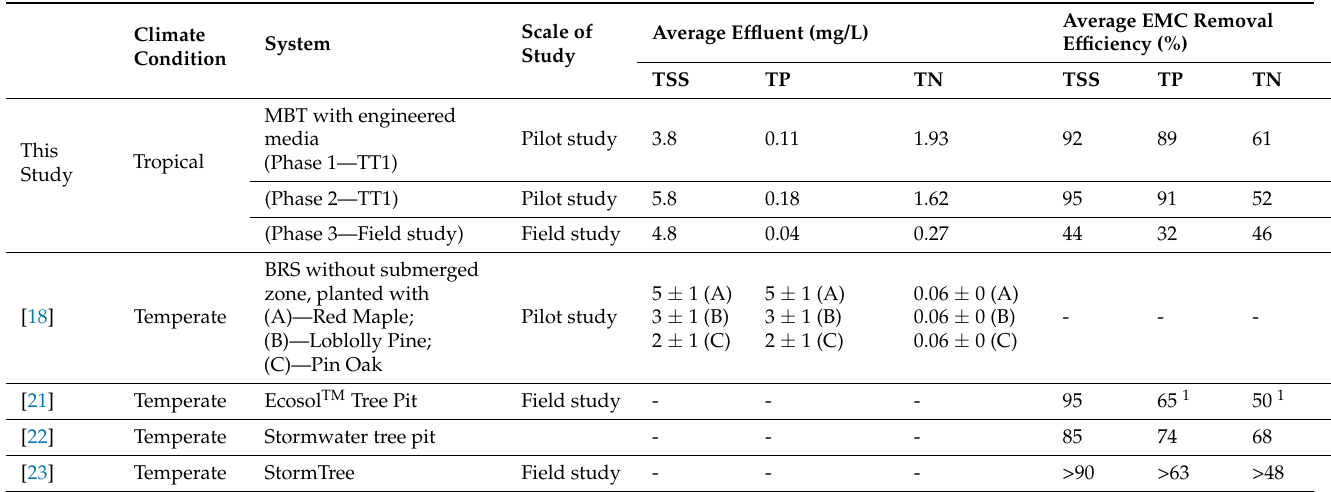
Table 2. Effluent pollutants EMC of the field MBT system and comparison with literature studies. Climate